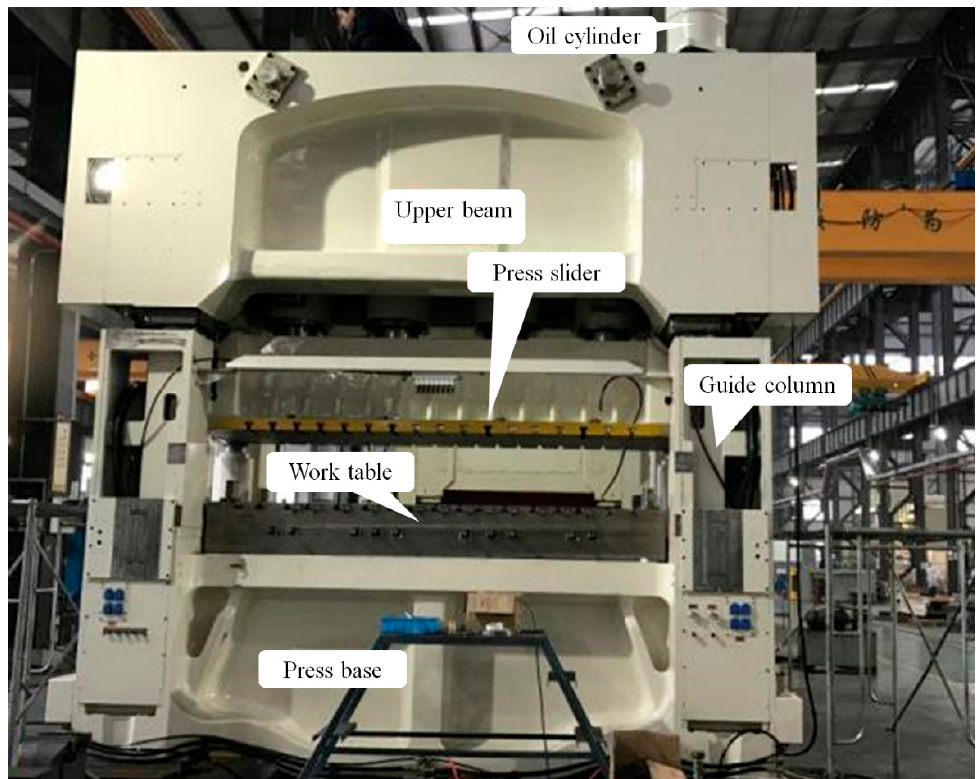
Figure 4. High-speed press developed from the optimum design obtained by the proposed heterogeneous technique for order preference by similarity to an ideal solution